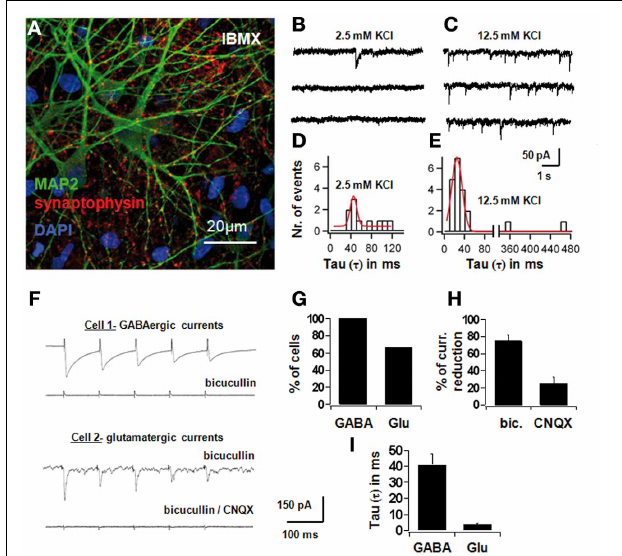
FIGURE 3 | Electrophysiological differentiation of NPCs in IBMX, with spontaneous and evoked synaptic currents. In (A) , confocal picture showing MAP2 and synaptophysin positivity after 7 days in differentiation medium with IBMX. Red is AlexaFluor568 and green is AlexaFluor488. In (B) and (C) , spontaneous synaptic recordings in voltage clamp in normal saline and with increased KCl (12.5mM). In (D) and (E) , histograms of the time constants of all synaptic events in normal saline and in increased KCl, fitted with a Gaussian curve; best-fit parameters were 37 ± 9ms for low KCl and 20 ± 14ms for high KCl. In (F) , synaptic currents in differentiated cells in vitro evoked through external bipolar macroelectrodes; each trace represents an average of ten consecutive signals subtracted from the stimulation artifact; stimulation parameters: 5 stimuli at 400ms 1 to 10V and 1ms pulse-duration, 10 sweeps. In Cell 1, synaptic currents with long decay time were induced and blocked completely with 10 μ M bicuculline methiodide, a selective GABA A -receptor antagonist; in cell 2, residual currents with short decay time persisted after blocking bicuculline, and this component disappeared after 10 μ M 6-cyano-7-nitroquinoxaline-2,3-dione (CNQX), an AMPA-antagonist. In (G) , the percentage of cells with GABAergic and glutamatergic synapses, in (H) , the percentage of current-reduction with bicuculline and CNQX, and in (I) the average time constants of the bicuculline- and CNQX-sensitive synaptic components, are depicted.